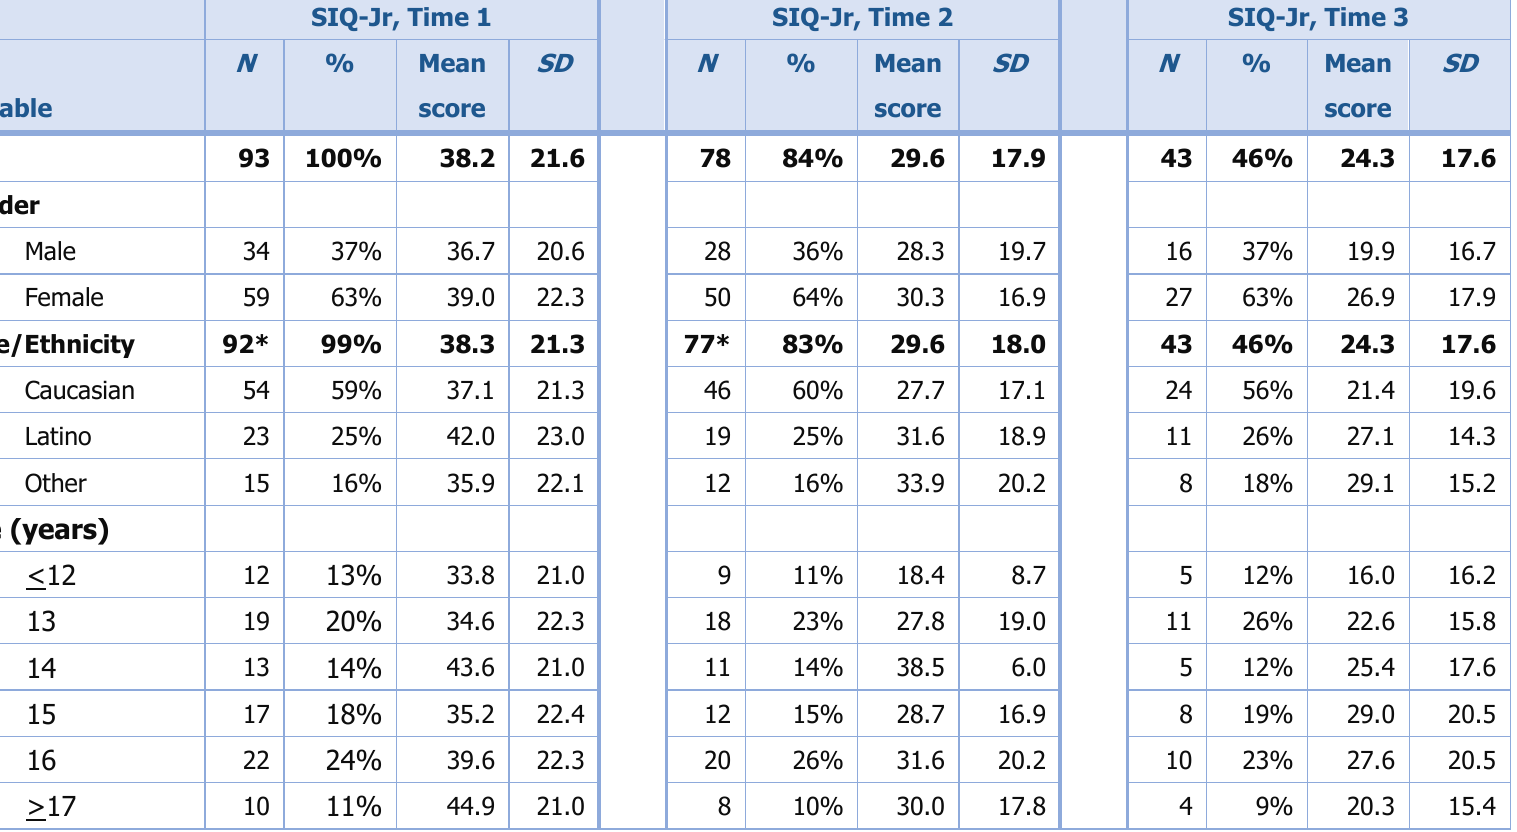
Table 1. SIQ-Jr Demographic and Mean Scores SIQ-Jr, Time